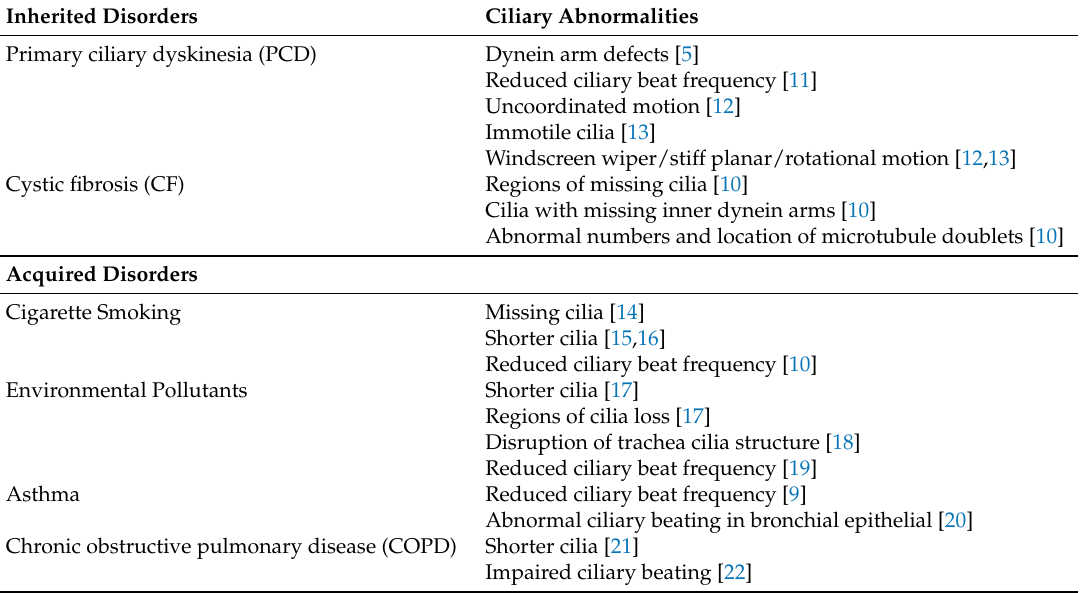
Table 1. Ciliary abnormalities due to inherited and acquired